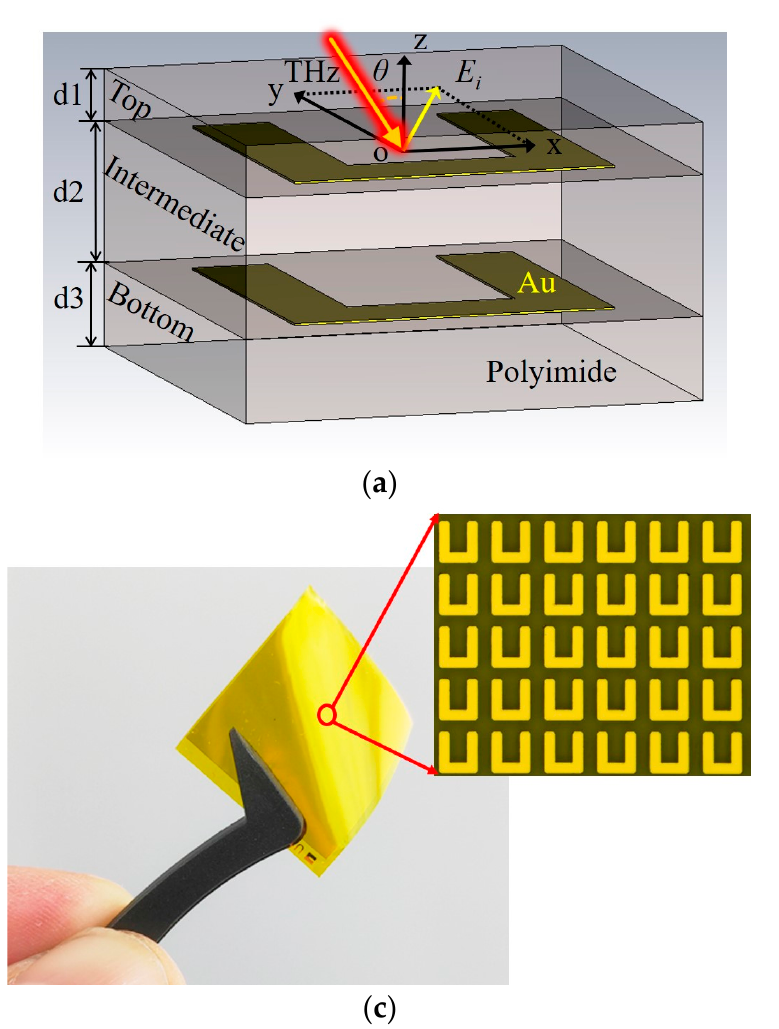
Figure 1. The structure of the designed QWP unit cell: ( a ) QWP unit cell structure designed using CST Microwave Studio; ( b ) structural dimensions of the U-shaped unit cell in the QWP; ( c ) a picture of the QWP in tweezers, where the upper right corner contains an image of the red circle area on the QWP, which has been magnified 1000 times.